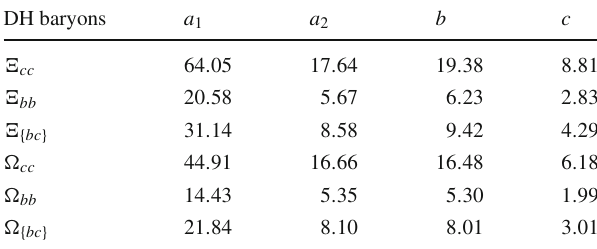
Table7 Spin-couplingparameters(inMeV)inthespininteraction(29) of the DH baryons (cid:2) QQ (cid:2) and (cid:3) QQ (cid:2) ( Q , Q (cid:2) = c , b ) in p wave DH